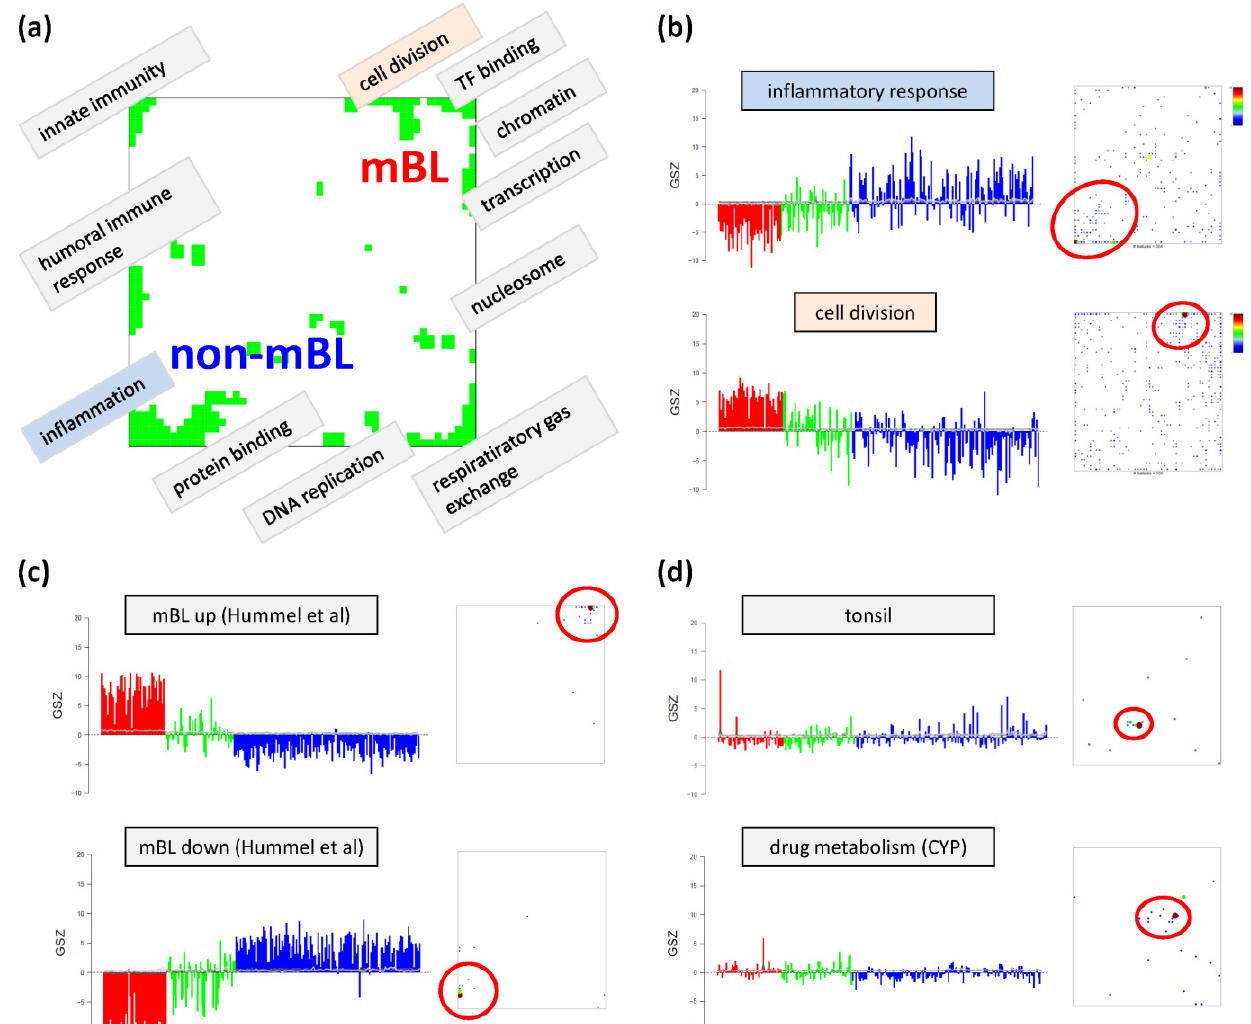
subtype. The respective gene set population maps reveal that the associated genes accumulate in the regions of spots overexpressed in the respective subtype, as expected. Figure 3. Functional analysis: ( a ) The functional context of the most abundant spots is assigned according to the topmost overexpressed gene sets in each of the spots. ( b (cid:177) d ) GSZ-profiles and population maps are shown for gene sets accumulating in the mBL and non-mBL specific overexpression spots as indicated by the red ellipses (panel b), for mBL- vs -non-mBL signature sets published previously [10] ( c ) and for sets accumulating in rare spots ( d